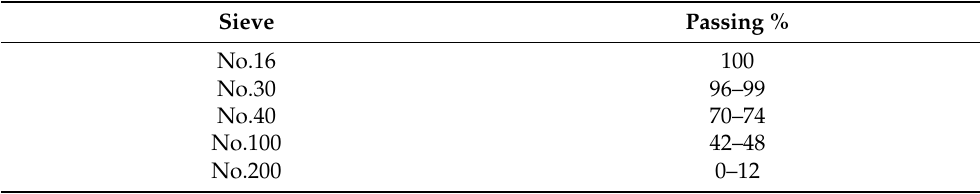
Table 2. Crumb rubber size and weight distribution used in this study.